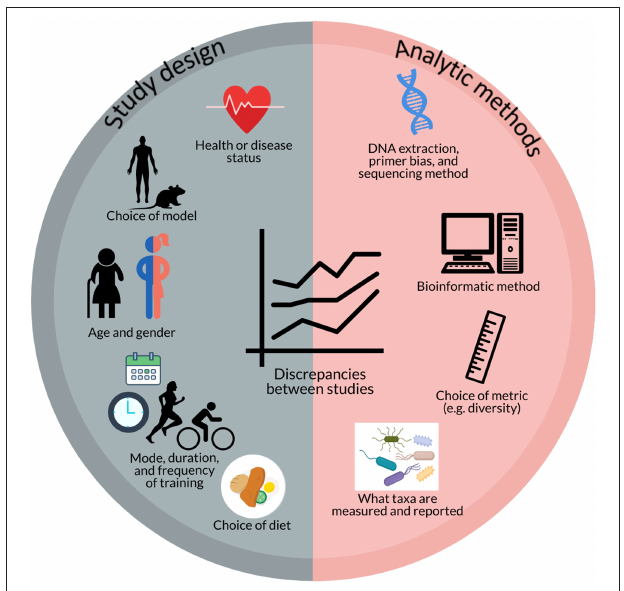
FIGURE 2 | Potential factors contributing to discrepancies between studies investigating the effect of exercise on the gut microbiome include aspects of study design (e.g., health or disease status; choice of model; age and gender; mode, duration, and frequency of training; and choice of diet) and analytic methods (e.g., DNA extraction, primer bias, and sequencing method; bioinformatic method; choice of metrics; and what taxa are measured and reported).